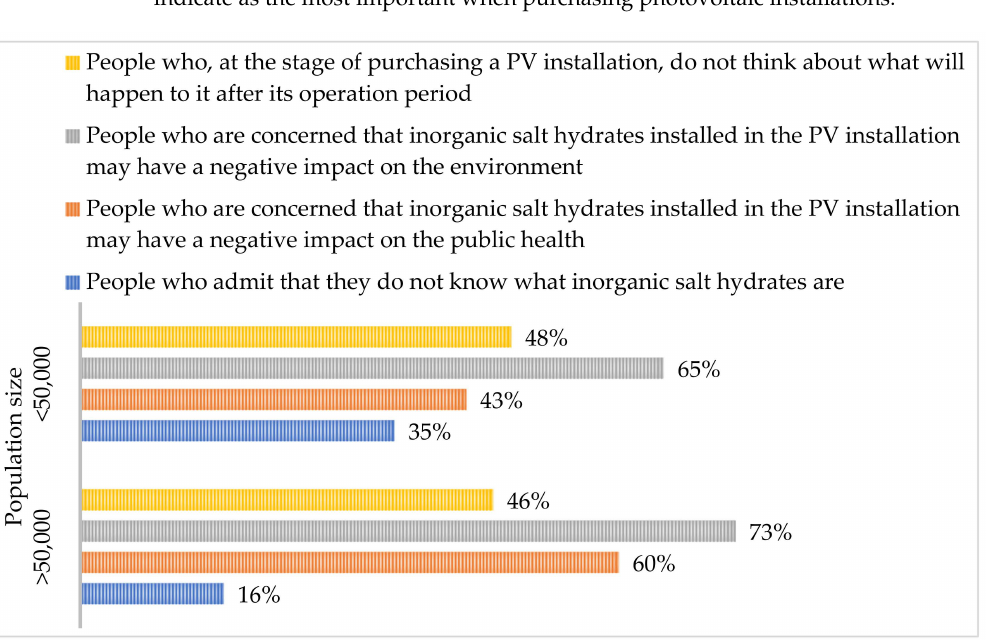
Figure 1. The criteria that residents (depending on the size of the population in which they live) indicate as the most important when purchasing photovoltaic installations.